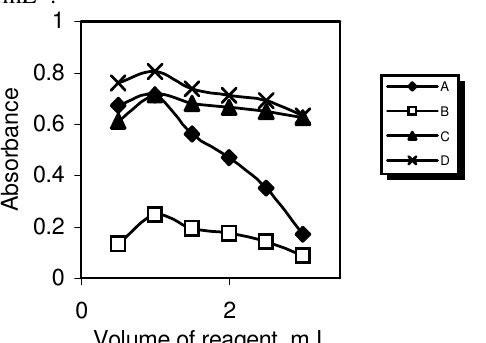
Figure 2. Effect of the volume of fast red B salt solution on its reaction with (A) secnidazole 12.5 µg.mL -1 , (B) niclosamide 6.25 µg.mL -1 (C) nifuroxazide 12.5 µg.mL -1 and (D) sulphasalazine 12.5 µg.mL -1 .